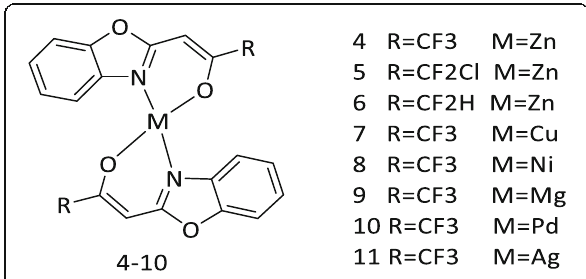
Fig. 41 2-Trifluoroacetonyl-benzoxazole metal complexes